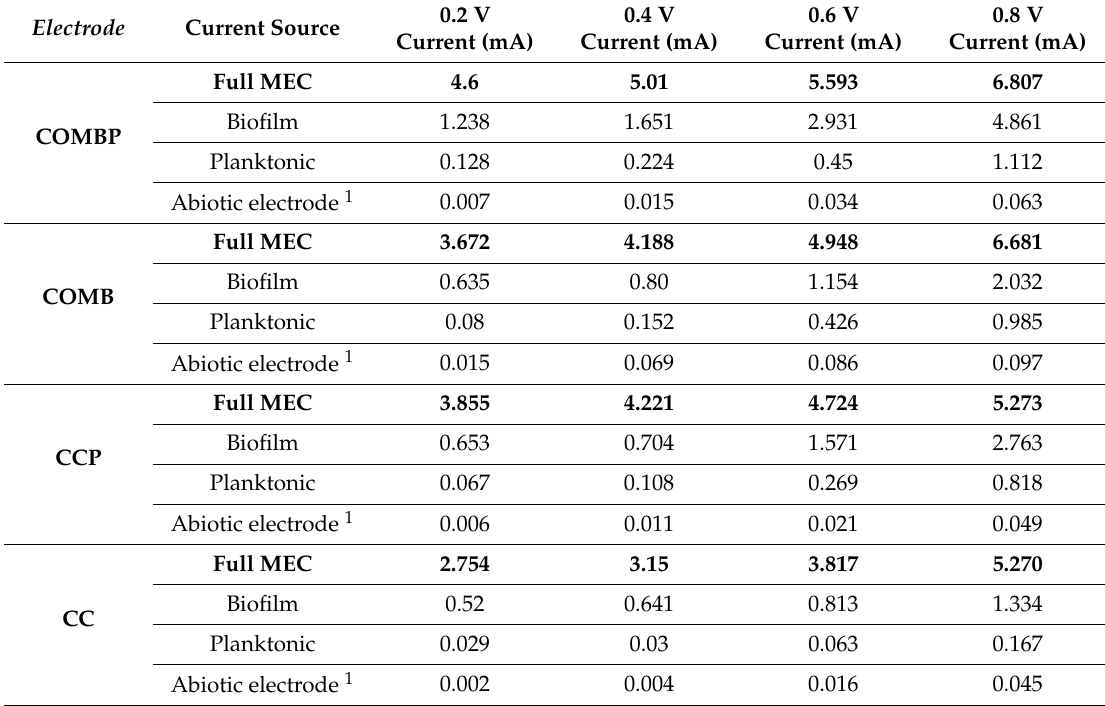
Table 1. Recorded currents under applied voltages of 0.2 V–0.8 V. vs. Ag / AgCl, from MECs based on the di ff erent anodes (COMBP, COMB, CCP and CC). Measurements were collected from the fully constructed MEC, the biofilm anode, the planktonic bacteria and the abiotic